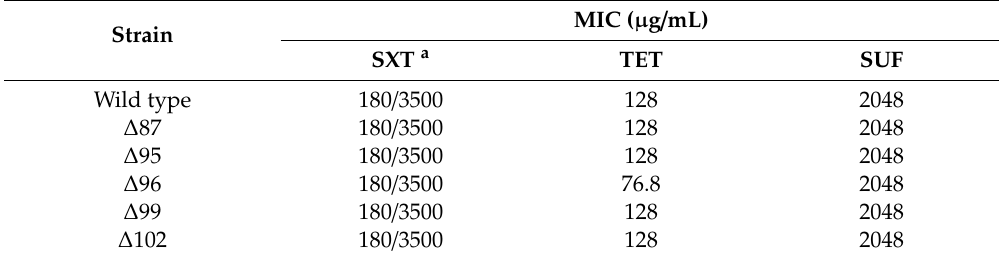
Table 2. Minimum inhibitory concentrations of the S. Agona strains. Minimum inhibitory concentrations (MICs) were determined by conducting each test in